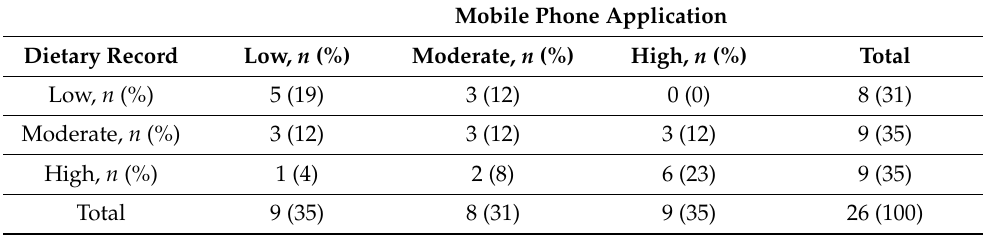
Table 3. Classification of dietary fiber intake into a low, moderate, or high intake of total fiber intake registered by the mobile phone application and the dietary record.